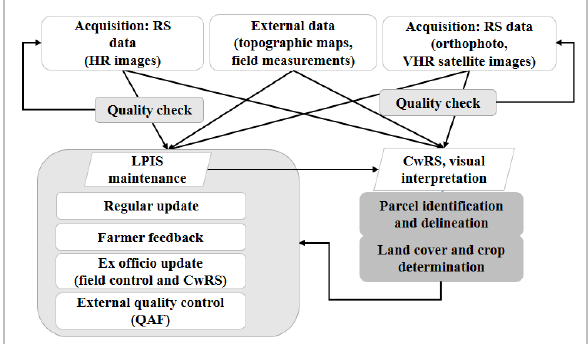
Figure 2. Simplified lifecycle scheme of Land Parcel Identification System (MePAR) and Control with Remote Sensing (CwRS) in